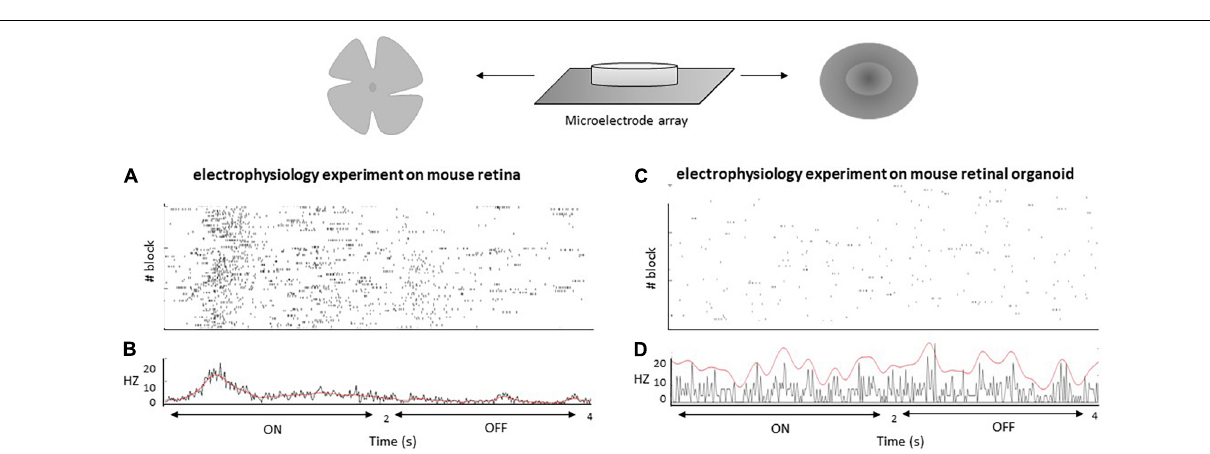
FIGURE 3 | MEA recordings from mouse retina at day P1 (A) and mouse retinal organoid at day 22 (C) . Frames (A,C) provide rastergrams of all responses for cells to visual stimulation blocks with a stimulus of 2 s ON and 2 s OFF that was cycled 25 times per block (3 blocks). Frames (B,D) provide peristimulus time histograms for all